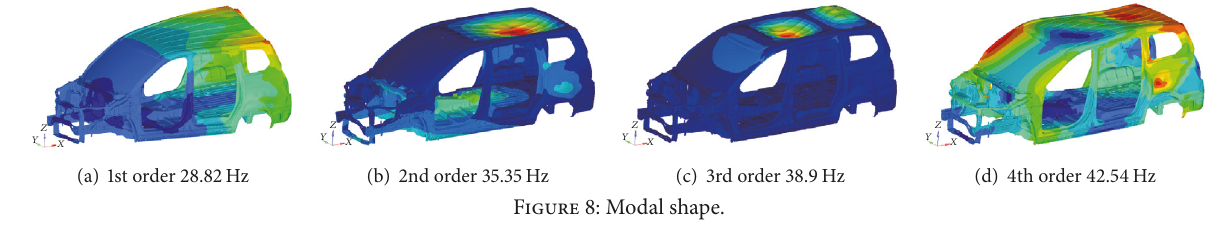
Figure 8: Modal shape.